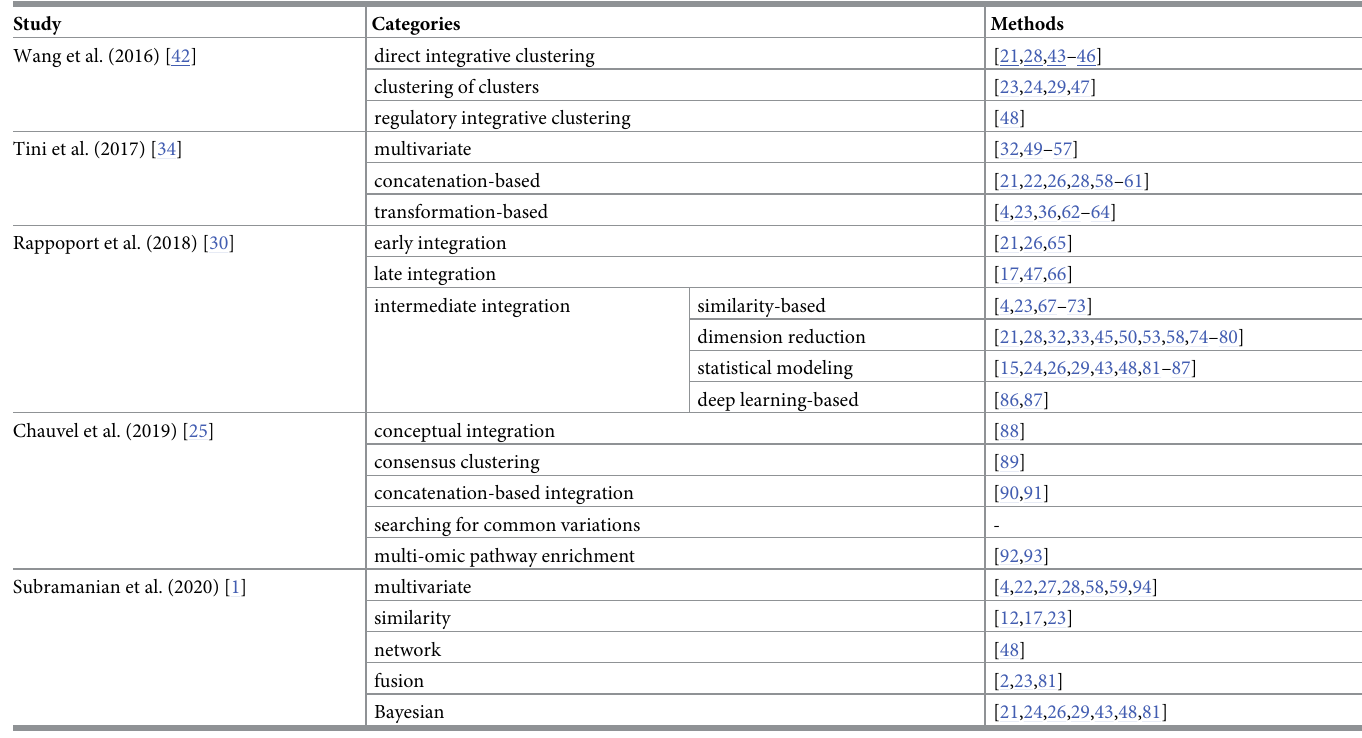
Table 1. Summary of previous